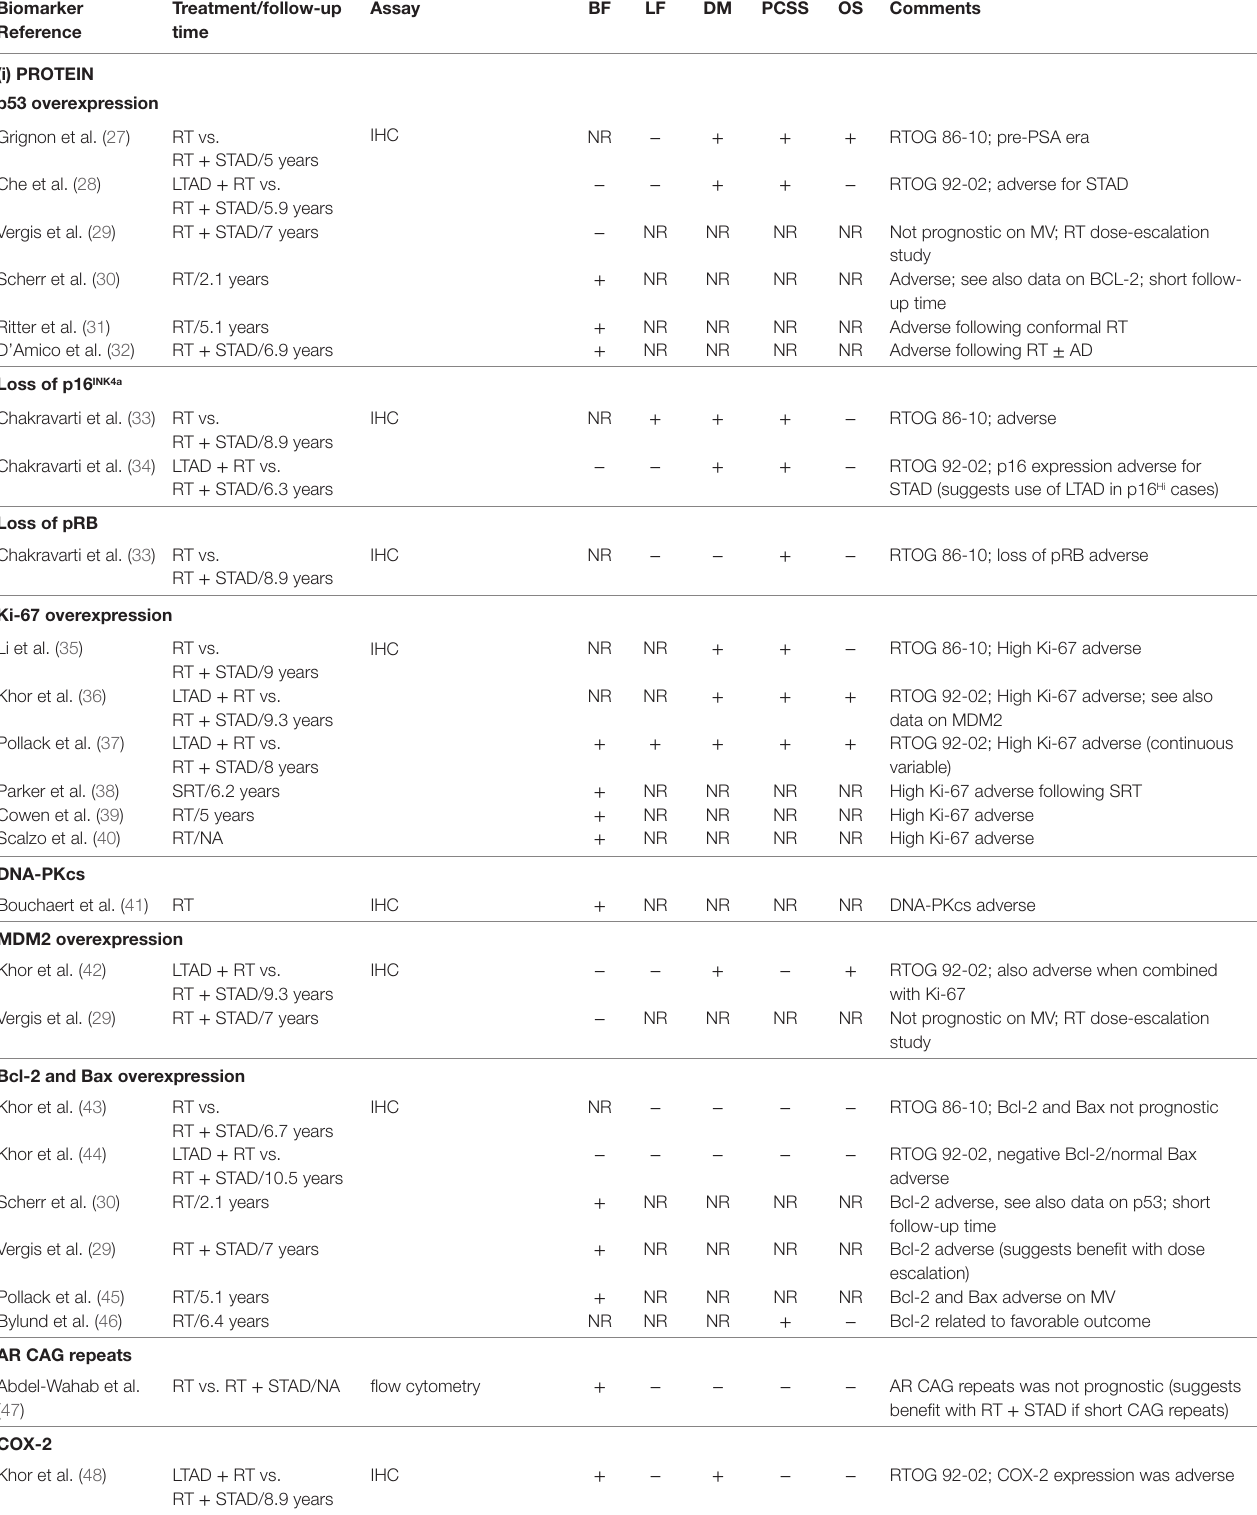
TABLe 1 | Selected biomarkers tested with prostate cancer